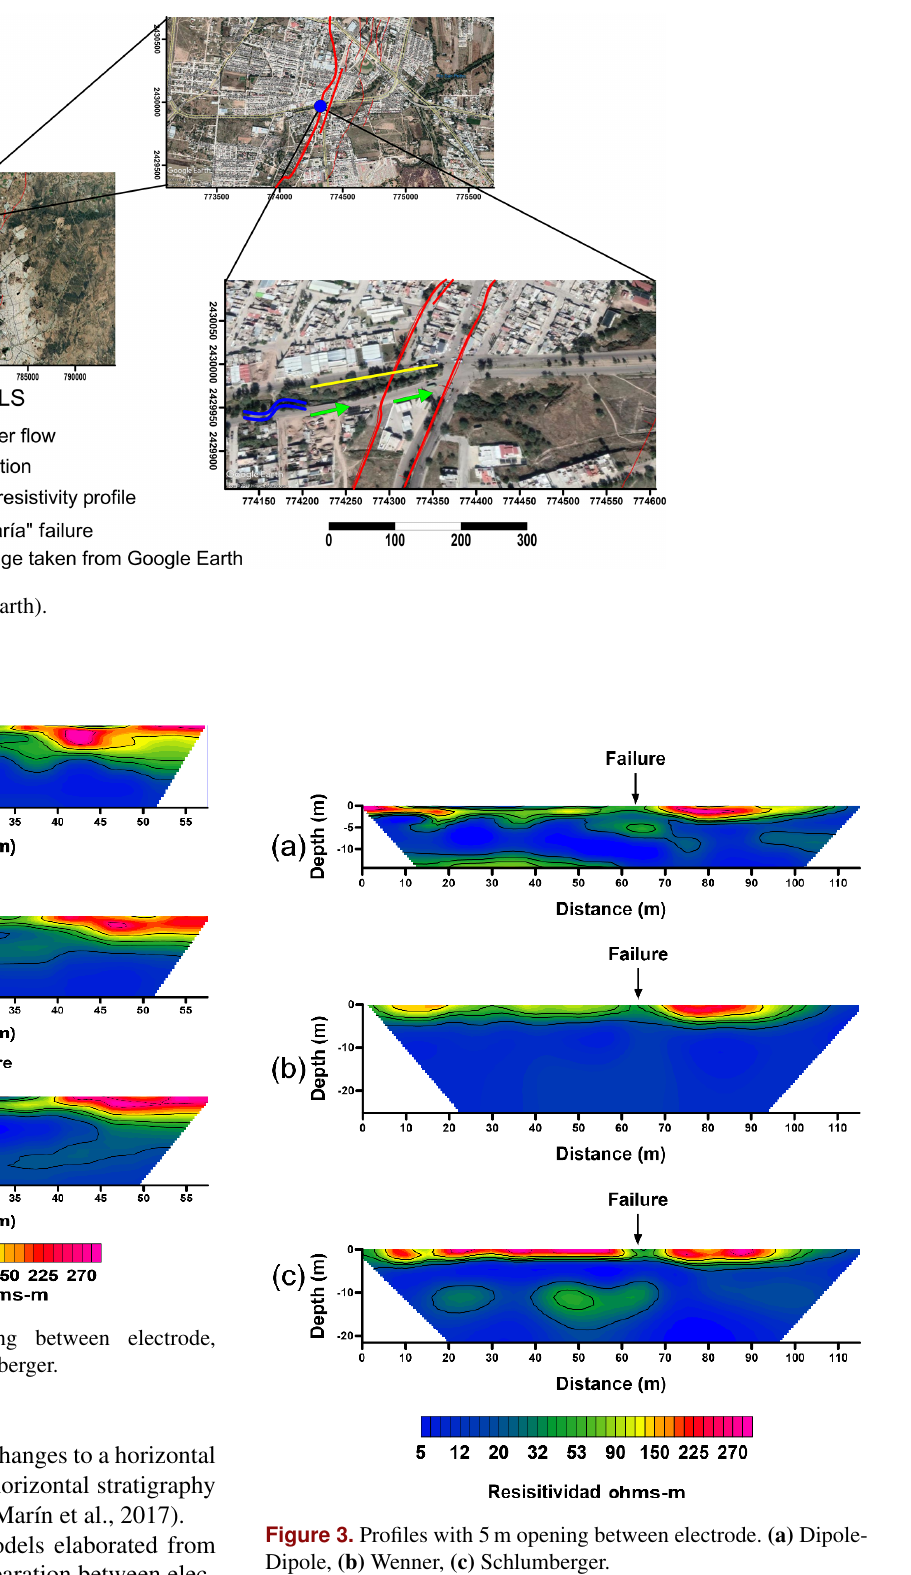
Figure 3. Profiles with 5m opening between electrode. (a) Dipole- Dipole, (b) Wenner, (c)